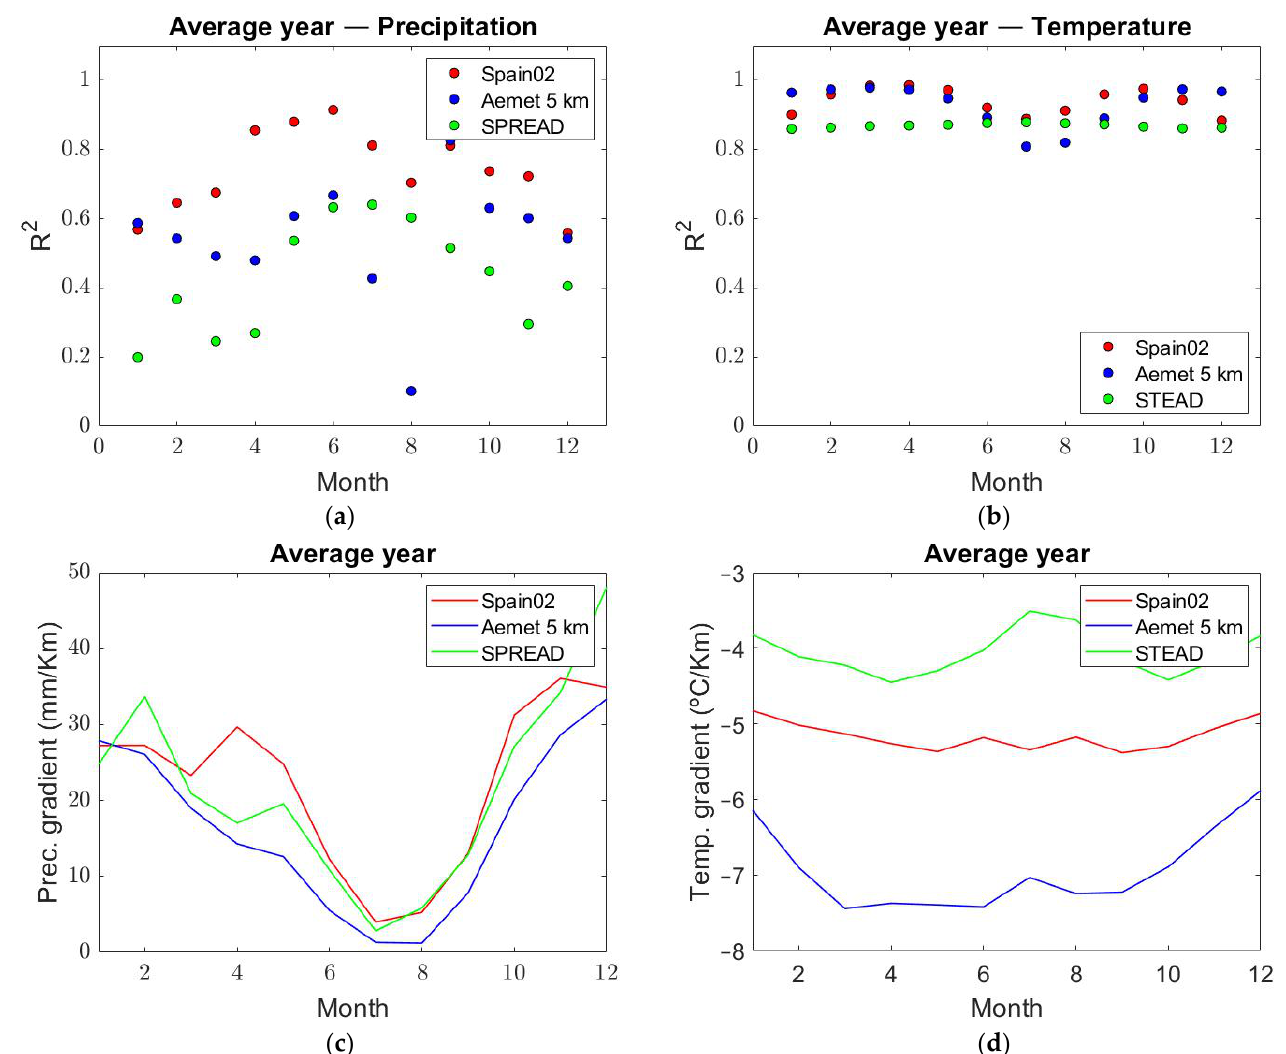
Figure 3. Temporal linear correlation coefficient with elevation for the different databases for ( a ) precipitation; ( b ) temperature. Aggregate temporal altitudinal gradient for the different databases for ( c ) precipitation; ( d ) temperature.